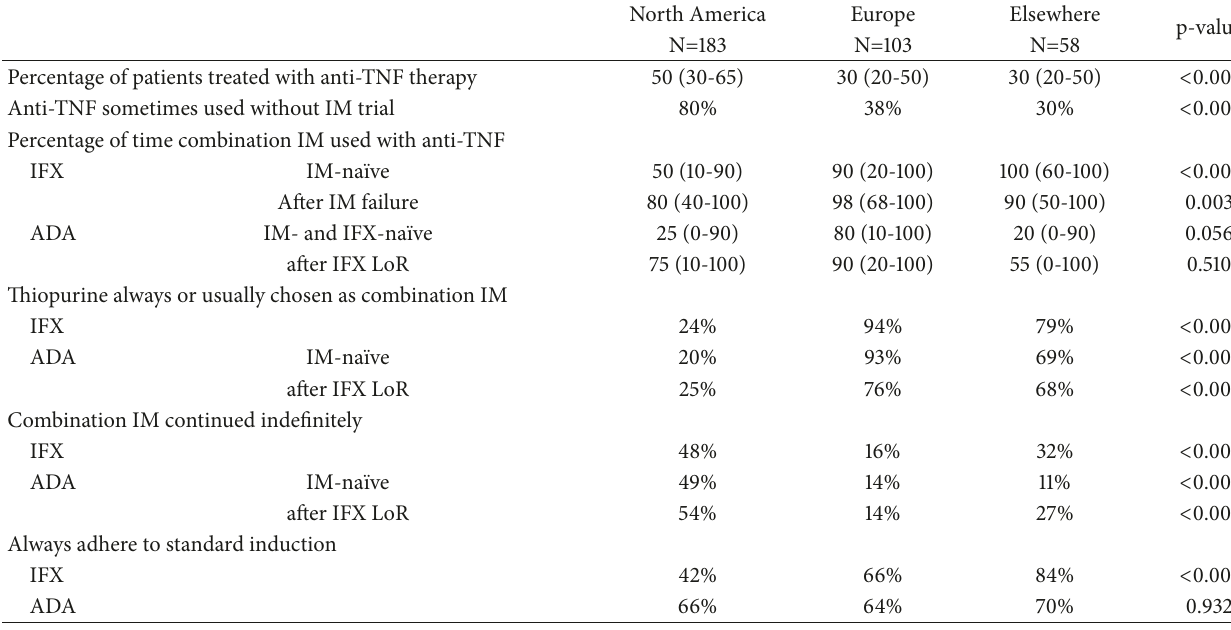
Table 2: Practice patterns in luminal Crohn’s disease with infliximab (IFX) and adalimumab (ADA). Results are presented as percentages or median (interquartile range) as appropriate.